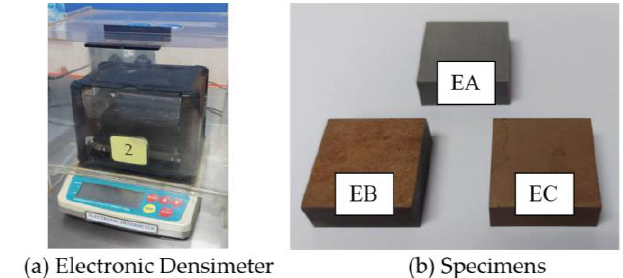
Figure 7. Density